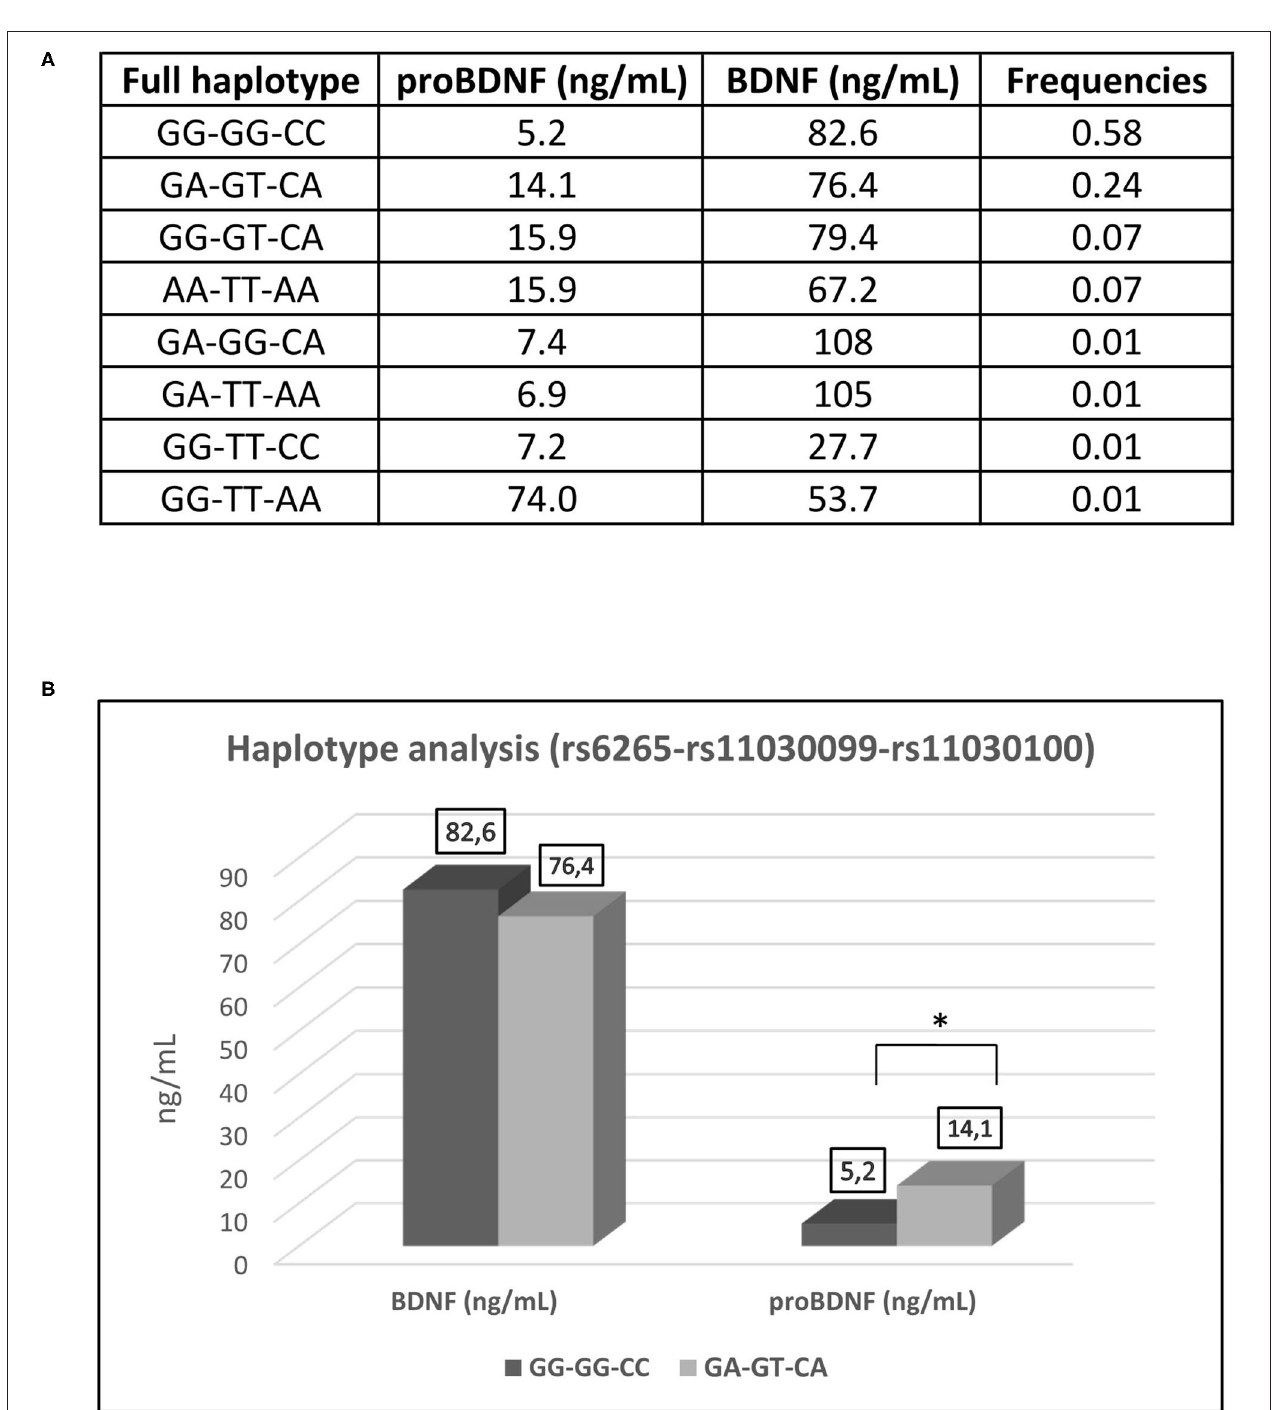
FIGURE 3 | Haplotype analysis of the SNP (rs6265-rs11030099-rs11030100). (A) Frequencies of haplotypes. (B) Haplotype analysis of GG-GG-CC (full wildtype haplotype) vs. GA-GT-CA (full heterozygous haplotype) in regard of serum concentration of BDNF and proBDNF. BDNF, brain derived neurotrophic factor; proBDNF, pro-brain derived neurotrophic factor. * p < 0.05.